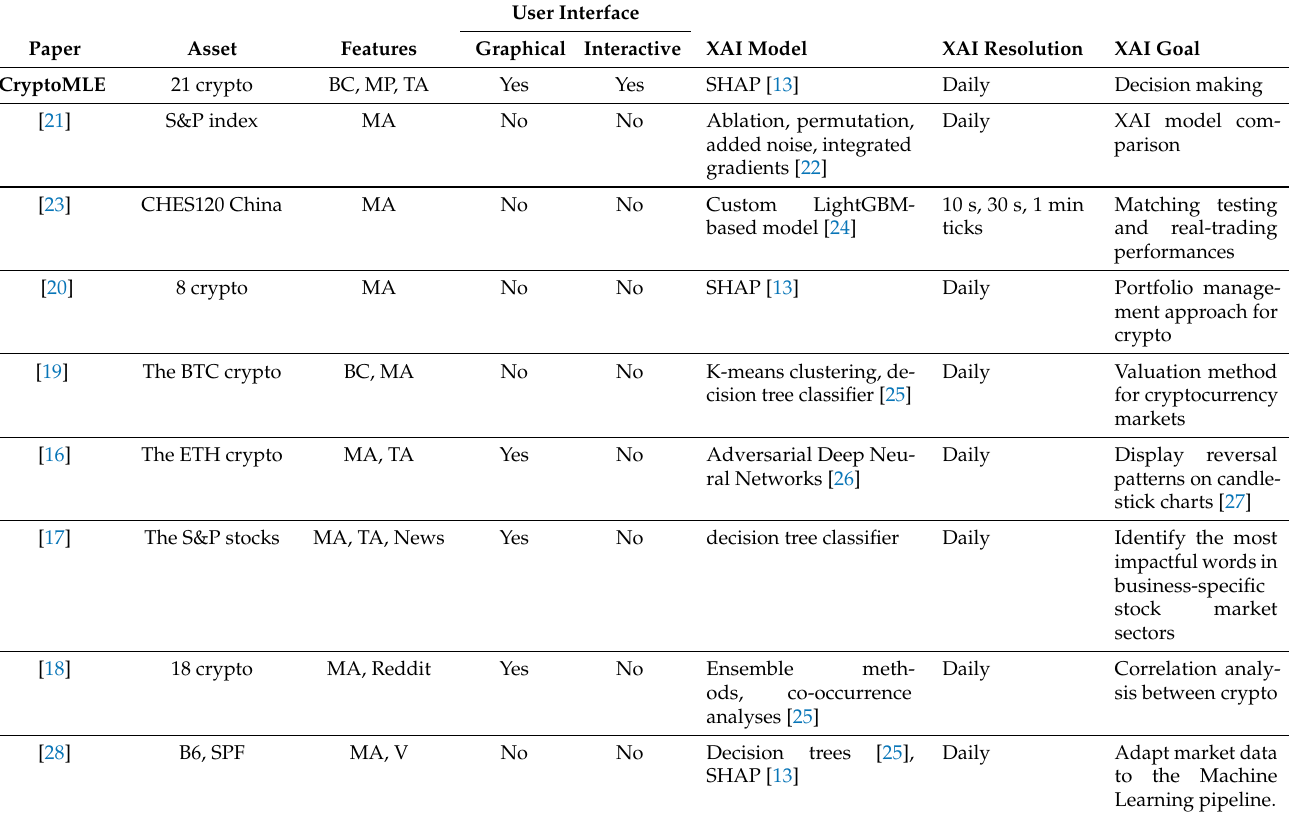
Table 1. Comparison with prior works. Legend: crypto = cryptocurrency/cryptocurrencies, BC = blockchain, MA = market data, V = Exchanged volumes, TA = technical analysis, B6 = CME Globex British Pound futures, SPF = S&P E-mini Futures. User